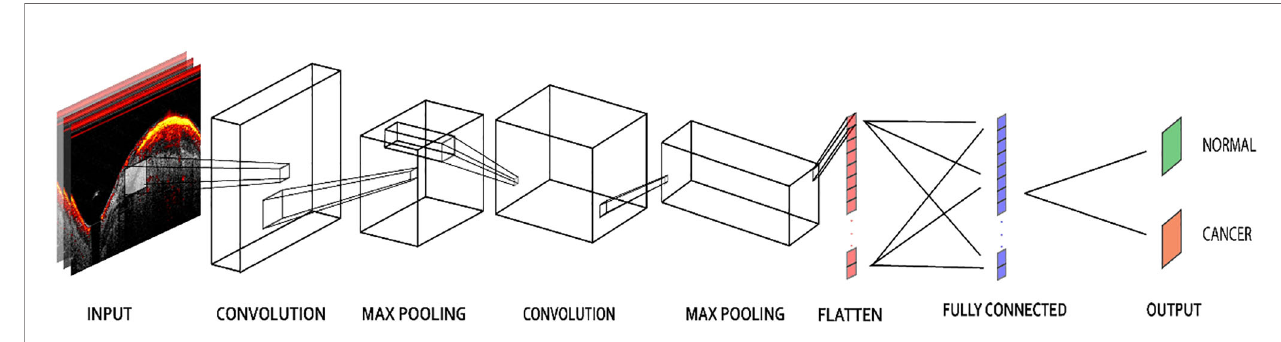
FIGURE 5 | Architecture of the CNN